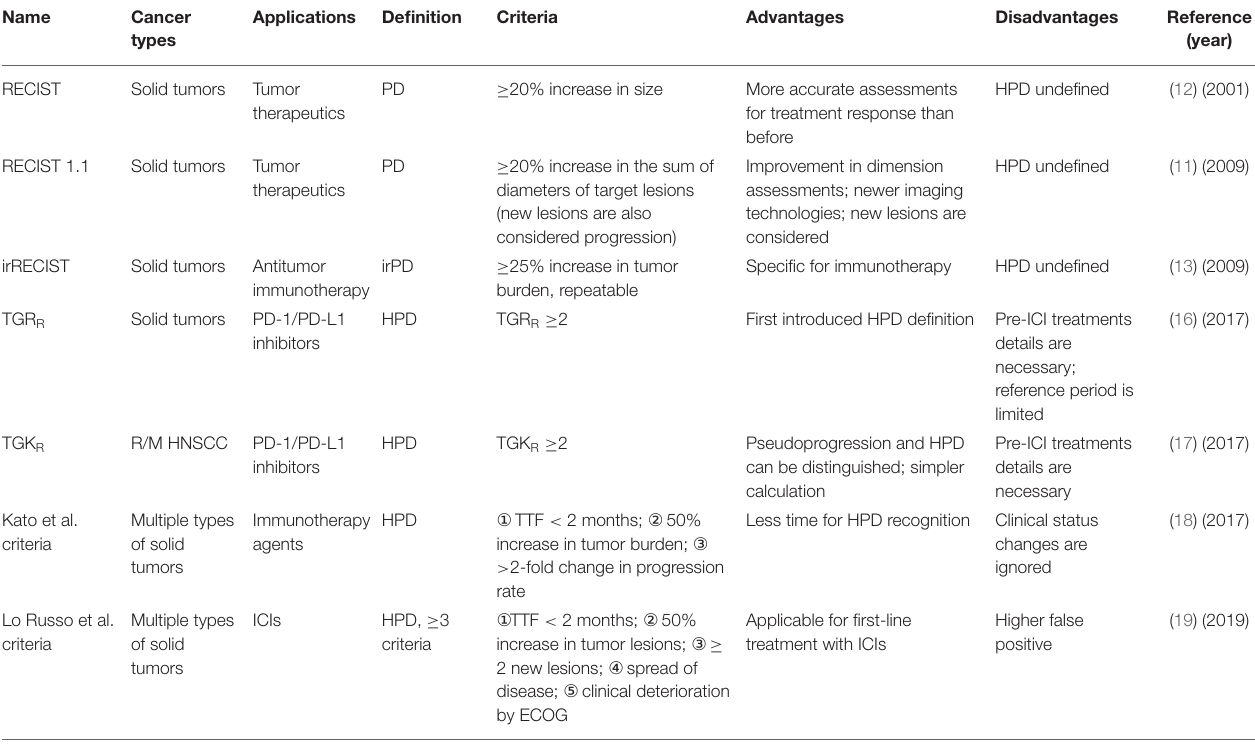
TABLE 1 | Different criteria for